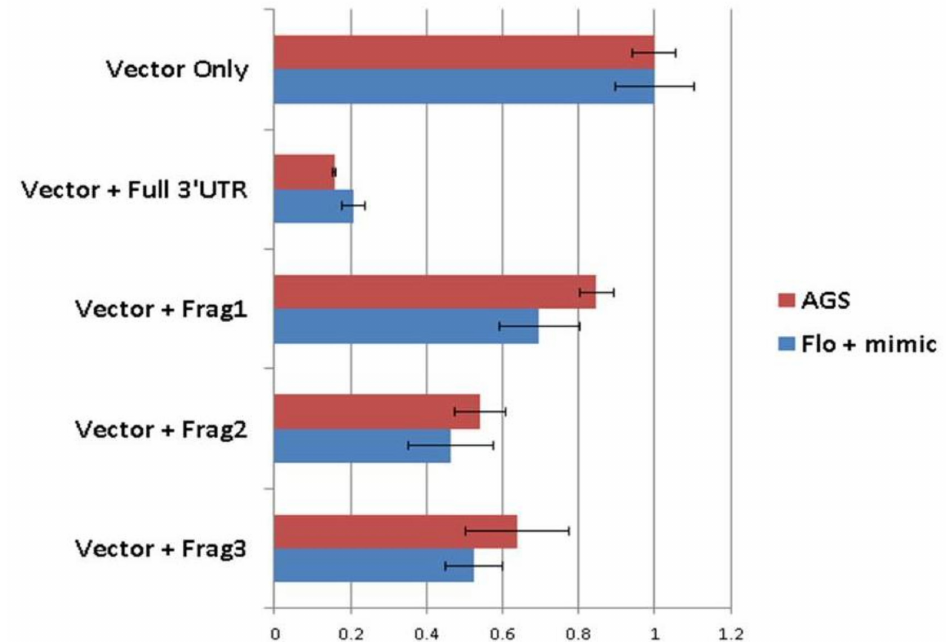
Figure 21. Significant reduction in luciferase activity induced by full-length 3 (cid:48) UTR insert in FLO-1 and AGS cells. Relative to luciferase activity after pmiRGLO vector-only transfection, the full-length 3 (cid:48) UTR insert caused the most significant reduction of luciferase activity in both FLO-1 and AGS cells. Vector + Frag1, 2, and 3 denote three different truncated PTCH1 3 (cid:48) UTR